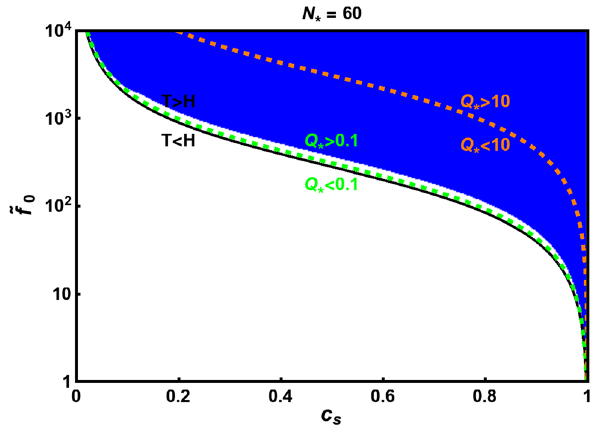
Fig. 4 Same as Fig. 3, but for N ∗ =